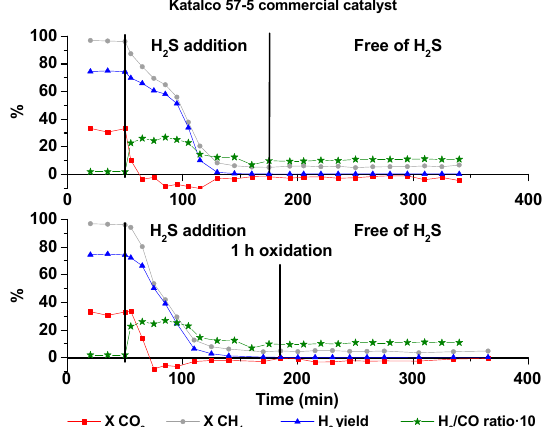
Figure 1. Katalco 57-5 Ni-Al 2 O 3 catalyst activity results. Top : self-regeneration. Bottom : Regeneration by oxidation. Reaction conditions: 210.0 mL/min CH 4 , 140.0 mL/min CO 2 , 197.7 mL/min N 2 , 52.5 mL/min O 2 , 0.169 mL/min H 2 O at 800 °C and atmospheric pressure. WHSV of 161.5 g gas ·g cat − 1 ·h − 1 (0.340 g of catalyst).